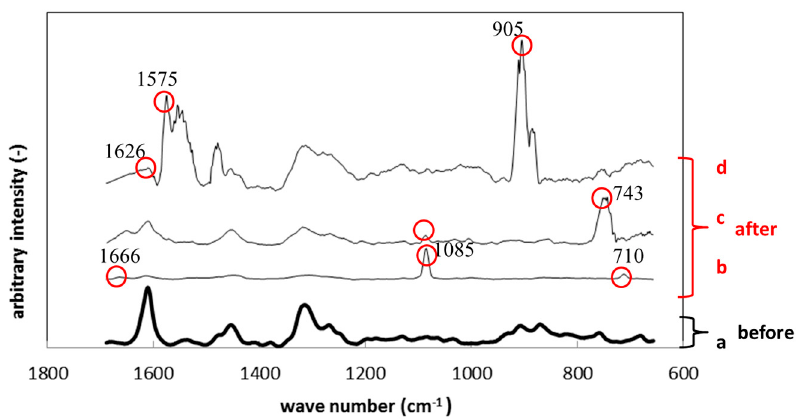
Figure 10. Raman shifts for the polyurethane specimens before ( a ) and after immersion ( b – d ).